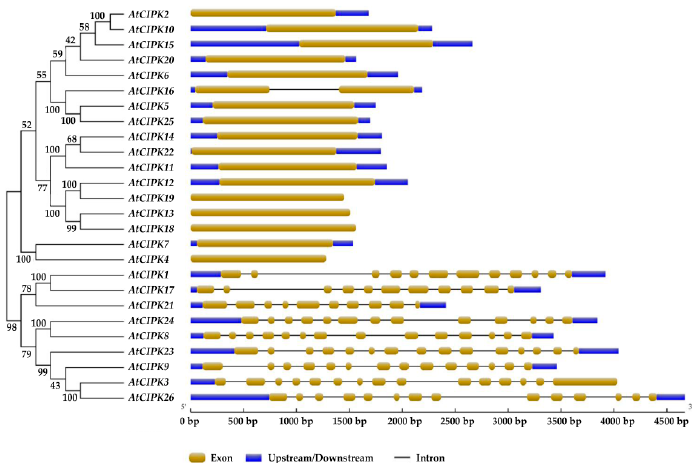
Figure 3. Phylogenetic analysis and intron ‐ exon distribution of CIPKs in A . thaliana . The amino acid sequences are available from UniProt. The coding sequences (CDS) and genomic sequences of CIPK s were available from The Arabidopsis Information Resource (TAIR). It is noteworthy that only the representative splice variant was selected for the analysis as to some genes having multiple splice variants. MEGA6 with Neighbor ‐ Joining method and online software GSDS 2.0 (gsds.cbi.pku.edu.cn/) were used for the analysis.